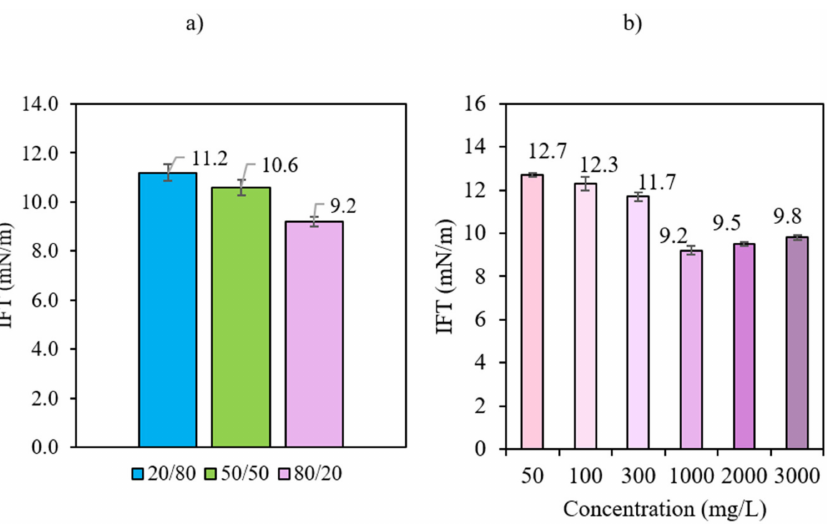
Figure 9. ( a ) Interfacial tension for ratios of 20:80, 50:50, and 80:20 AGC:bio-ethanol at a fixed concentration of AGC of 1000 mg · L − 1 . ( b ) Interfacial tension for concentrations of 50, 100, 300, 1000, 2000, and 3000 mg · L − 1 of AGC in brine at 80:20 ratio AGC:bio-ethanol solution. Measures at 25 ◦ C by the Du-Noüy ring Method. Measurements were performed in triplicate, and error bars represent standard